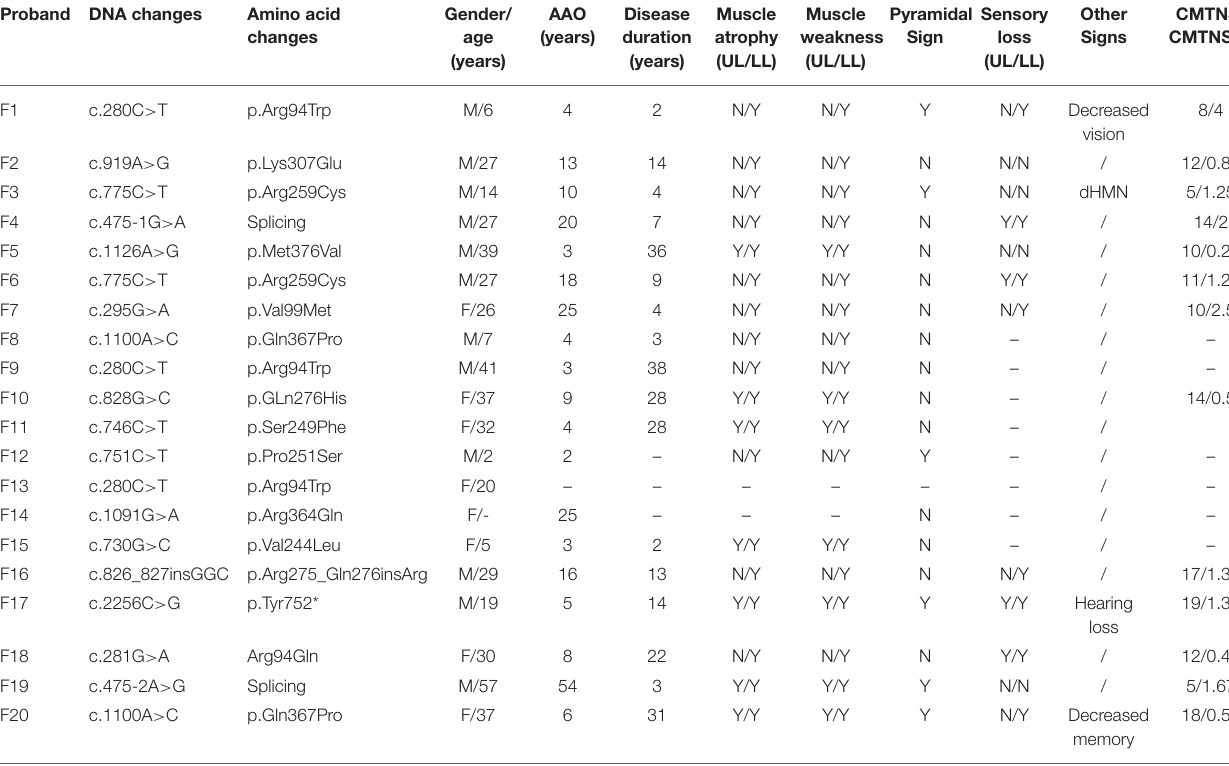
TABLE 1 | Clinical information of 20 identified mitofusion2 (MFN2) pedigrees in our cohort. Proband DNA changes